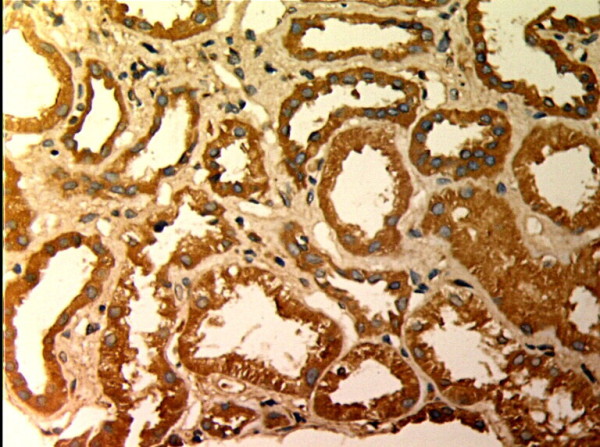
MMP-2 expression in renal tissue with different degree of inflammatory infiltration(EnVision assay; original magnification × 200). IF/TA-I Group.